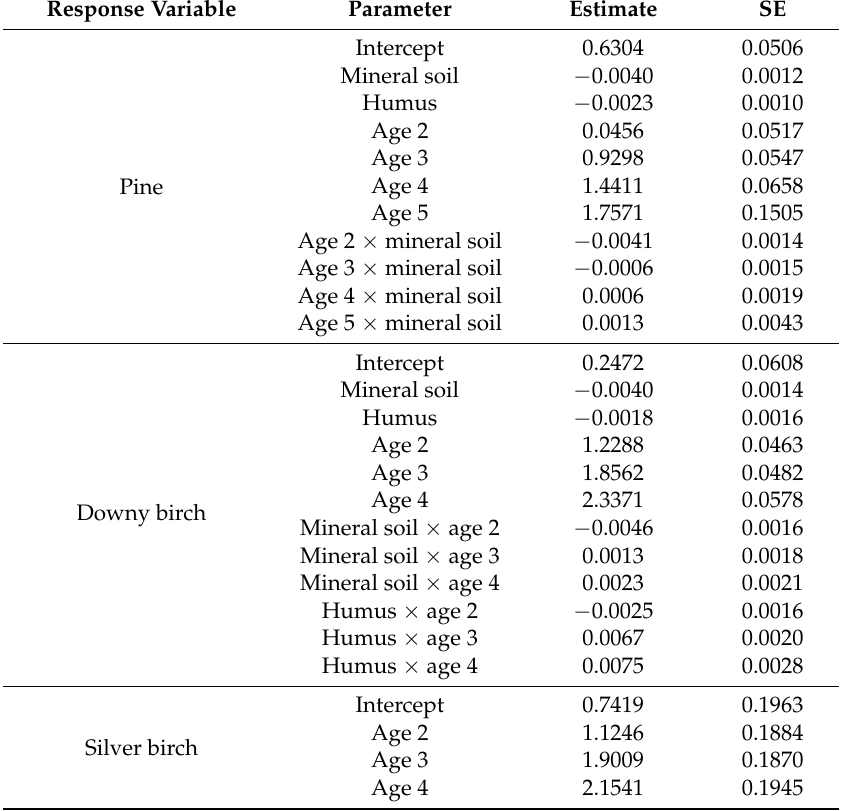
Table 5. Final model parameters with corresponding estimates and standard errors for current annual growth of Scots pine, downy birch, and silver birch, respectively. Models were fitted as LMMs with normal error distribution. The response variable, length of top shoot, was ln-transformed. Plot nested within sampling point nested within stand was included as a random intercept for all